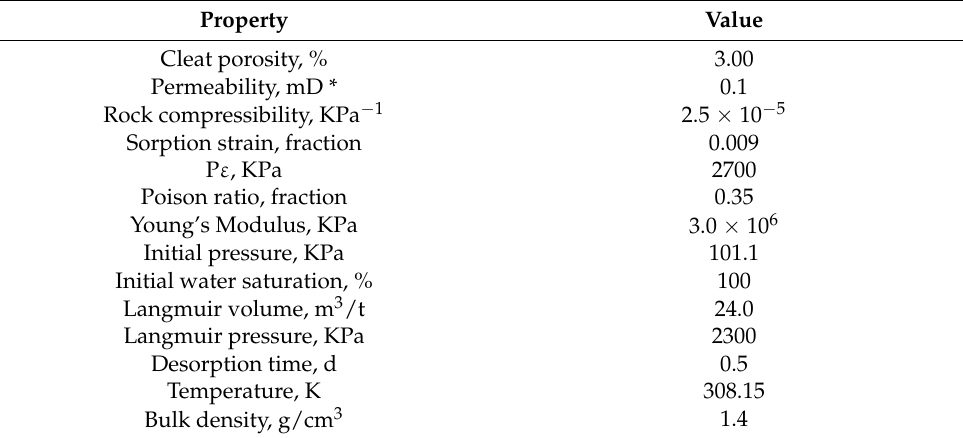
Table 1. Coal properties used in the synthetic numerical